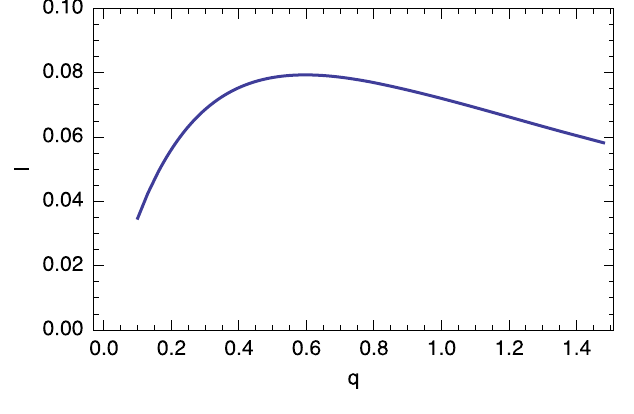
system.FIG. 3. Plot of function I ð q; q Þ versus q